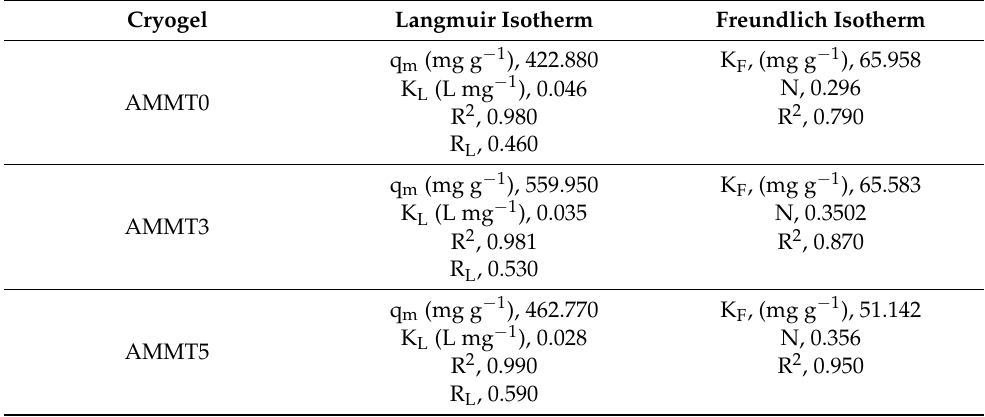
Figure 9. Non-linear regression of kinetic models on the MB retention by AMMT0, AMMT3, and AMMT5 samples (initial dye amount: 25 mg L − 1 , adsorbent dosage: 0.01 g, temperature: 25 °C, vol- ume: 10 mL).